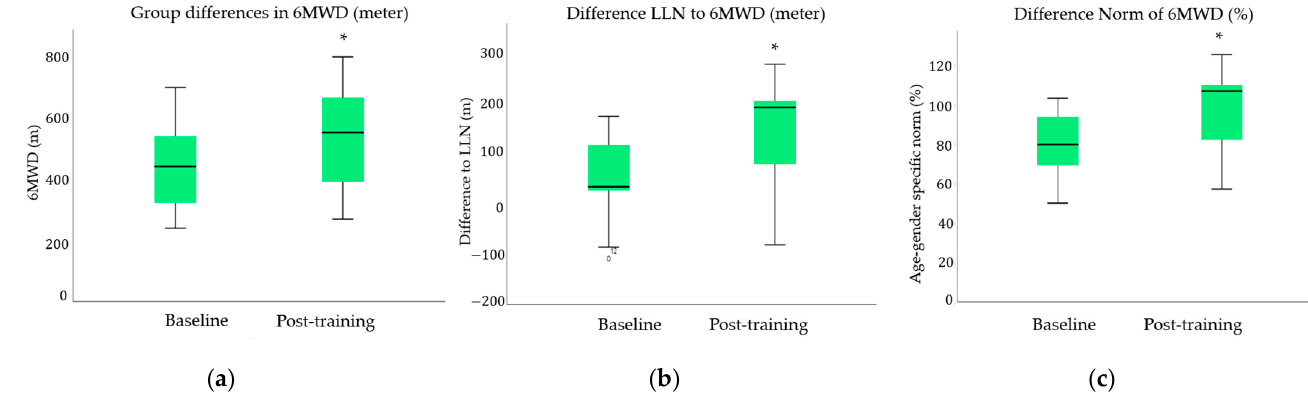
Figure 2. Illustration of clinical data with changes in physical performance: Group mean changes in ( a ) 6MWD (meter), ( b ) difference to the gender-specific lower limit of normal (LLN), ( c ) change in age-gender specific norm expressed in percentages. Statistically significant changes are indicated with the * with p ≤ 0.001; Difference Norm of 6MWD (%) was obtained from Wilcoxon-sign rank test.